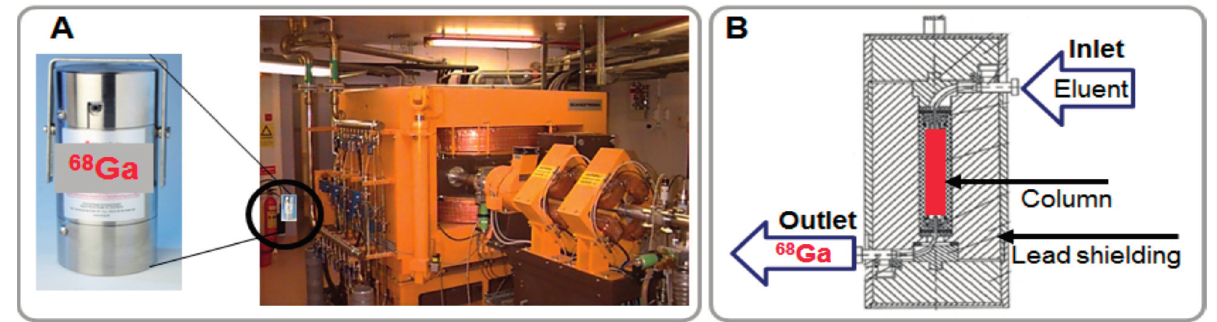
Figure 2. ( A ) Pictures of a 68 Ge/ 68 Ga generator and a cyclotron; ( B ) Schematic presentation of the cross section of a column-based